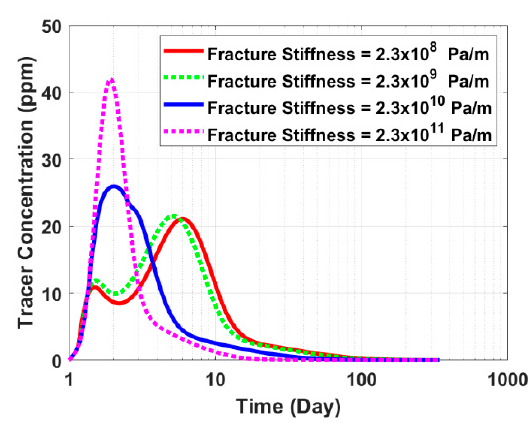
Figure 21. The impact of fracture stiffness (closure rate) on tracer response curves from a complex